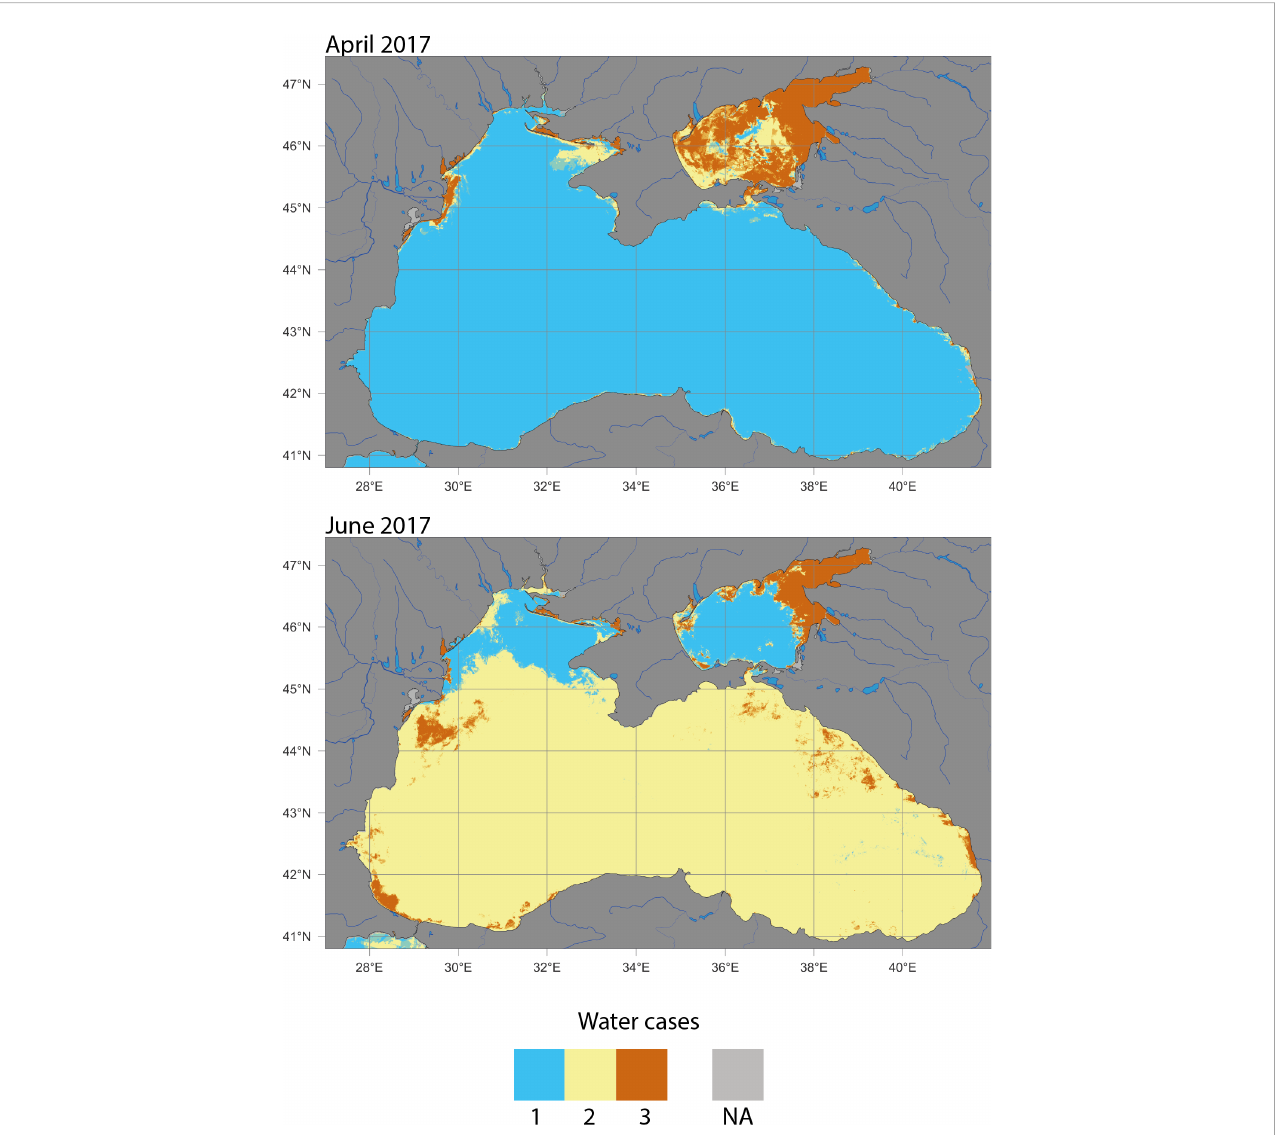
FIGURE 11 Water classi fi cation as Case 1, 2 or 3 (see the text for de fi nitions) as monthly composites in April 2017 (top) and June 2017